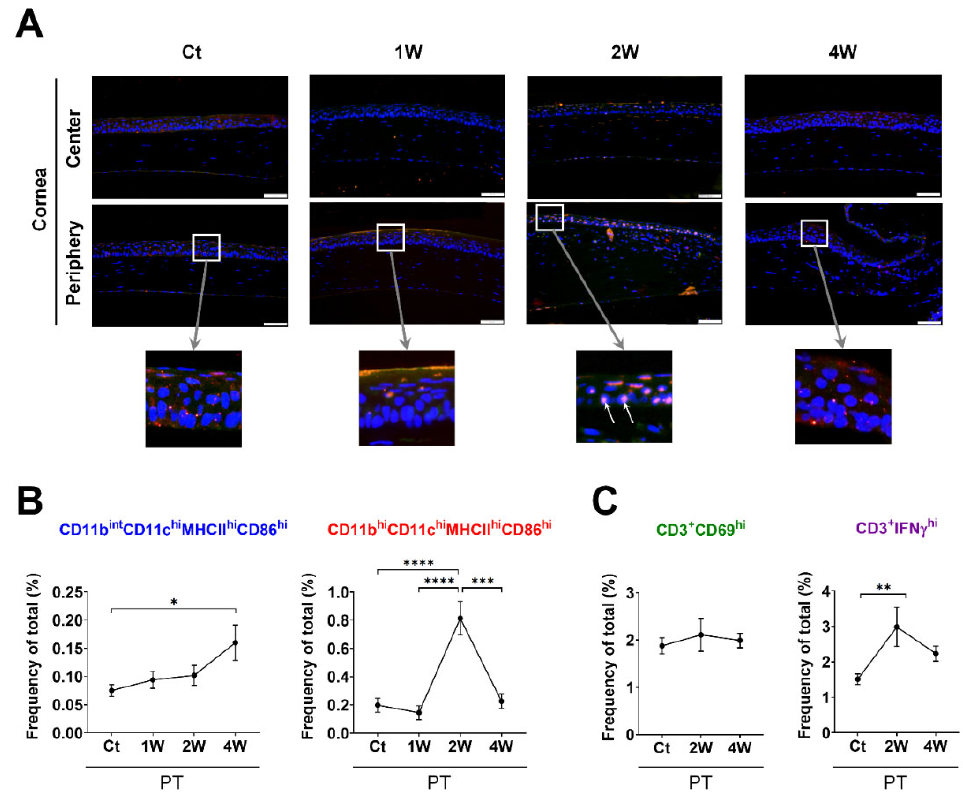
Figure 2. Time-dependent serial changes in APC subsets and T cells in the ocular surface in response to quiescent sterile inflammation using partial trephination until 4 weeks. ( A ) In immunofluorescent staining photographs, numerous MHCII-expressing cells were observed in the corneal epithelial layer at 2 weeks (white arrows) (scale bars: 50 µ m). ( B , C ) Time-dependent frequency (% of total) changes in the CD11b int CD11c hi MHCII hi CD86 hi and CD11b hi CD11c hi MHCII hi CD86 hi subsets ( B ) and T-cell subsets ( C ) in the ocular surface. The proportions of CD11b int CD11c hi MHCII hi CD86 hi cells increased over time. The frequency of IFN γ hi T cells increased at 2 weeks during the 4 week observation period. n = 5 for each time point and n = 12 for Ct; ANOVA followed by Bonferroni’s post hoc analyses. * p < 0.05, ** p < 0.01, *** p < 0.001 and **** p < 0.0001. Values are expressed as mean ± standard error measurement. Ct indicates the control group and PT the partial trephination group. Abbreviations: APC, antigen-presenting cell; IFN γ , interferon